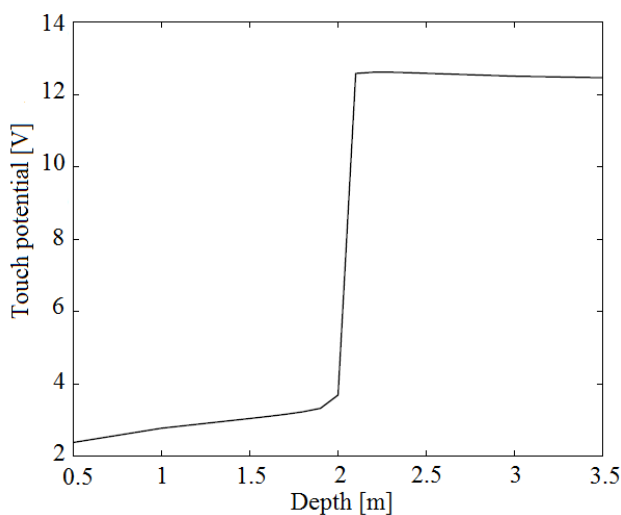
Fig. 15 Touch potential ( V t ) versus depth ( D